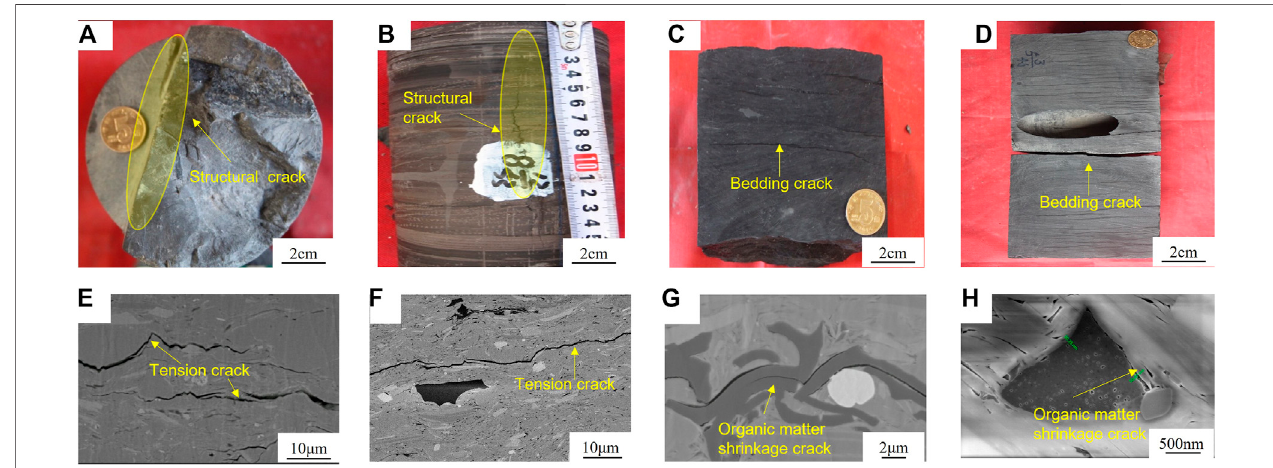
FIGURE 3 | Microcracks of the continental shale reservoir in northeastern Sichuan Basin. (A) Da ’ anzhai Member from YL-4 Well, 4004.25 – 4004.43 m, structural crack without fi lling; (B) Dongyuemiao Member from FY-1 Well, 2707.2 – 2707.4 m, structural crack; (C) Da ’ anzhai Member from YL-4 Well, 4053.12 — 4053.22 m, bedding crack; (D) Dongyuemiao Member from XL-101 Well, 2268.97 – 2269.12 m, bedding crack; (E) Da ’ anzhai Member from YL-4 Well, 3789.34 m, microscopic tension crack; (F) Dongyuemiao Member from XL-101 Well, 2275.55 m, microscopic tension crack; (G) Da ’ anzhai Member from YL-4 Well, 3789.34 m, organic matter shrinkage crack; (H) Dongyuemiao Member from XL-101 Well, 2269.69 m, organic matter shrinkage crack.